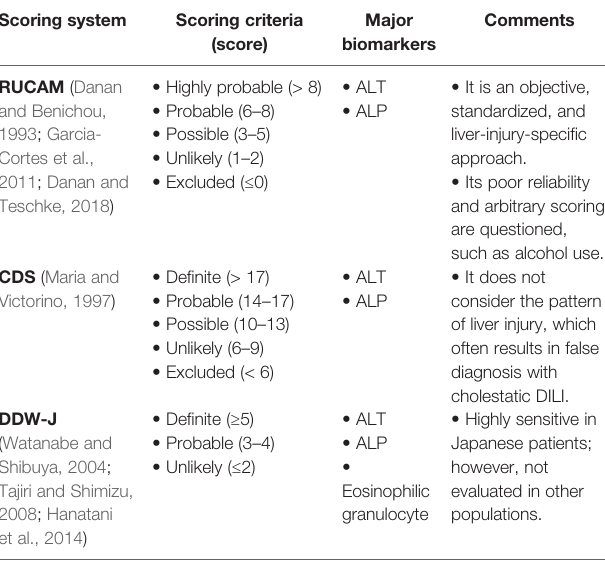
TABLE 1 | Scoring Systems Applied to Diagnose